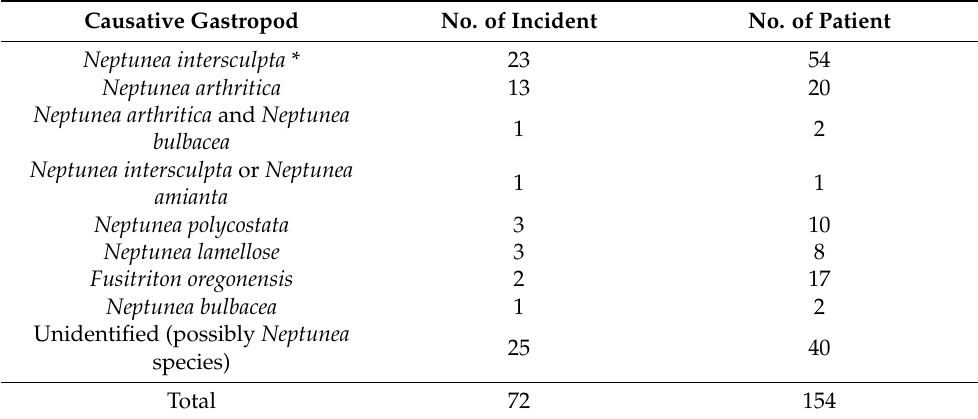
Table 4. Incidence of tetramine poisoning caused by marine gastropods in Japan over the last 20 years (cumulative 2001–2020). Causative Gastropod No. of Incident No. of Patient Neptunea intersculpta * 23